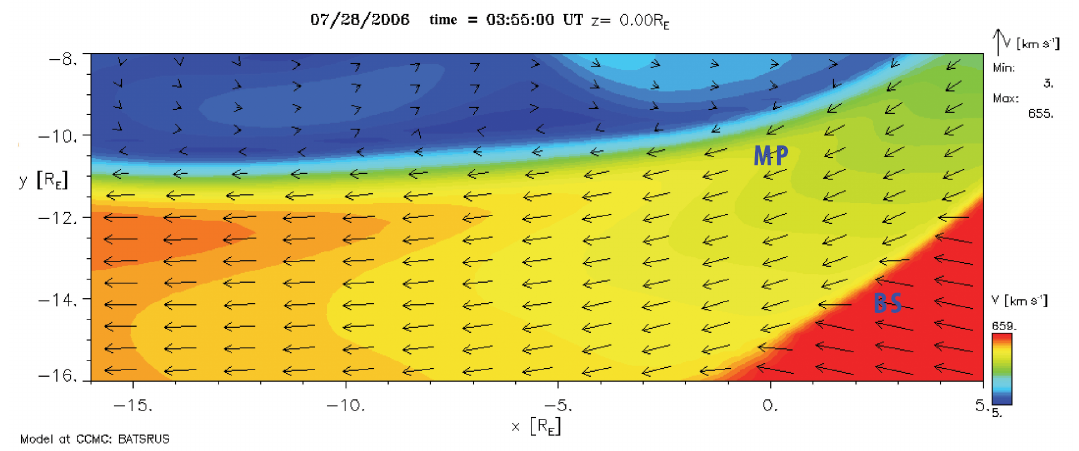
Figure 12. Close-up of the X – Y cut at 03:55UTC when no vortex is visible. Quantities shown are the same as the ones in Fig. 9. The flow speeds along the boundary are not as high as those on the solar wind.